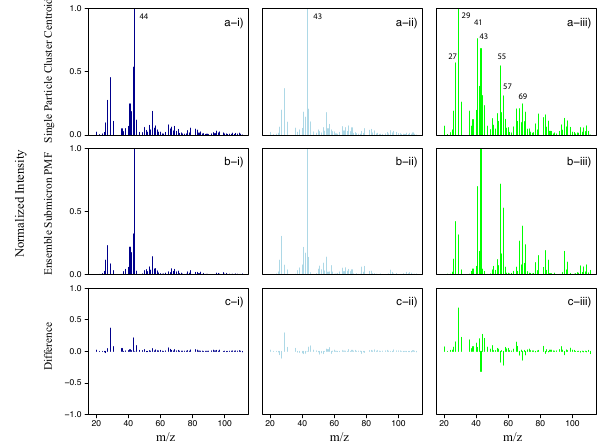
Fig. 6. (a) Cluster centroid (group-average mass spectrum) for (i) cluster I, (ii) cluster II, and (iii) cluster III particles. (b) Mass spec- trum for (i) the high O/C alkane SOA factor, (ii) the low O/C alkane SOA factor, and (iii) mass-weighted average for the COA, PO SOA, and nighttime OA factors identified from the ensemble measure- ments using PMF analysis. (c) The difference between spectra in (a) and (b) .